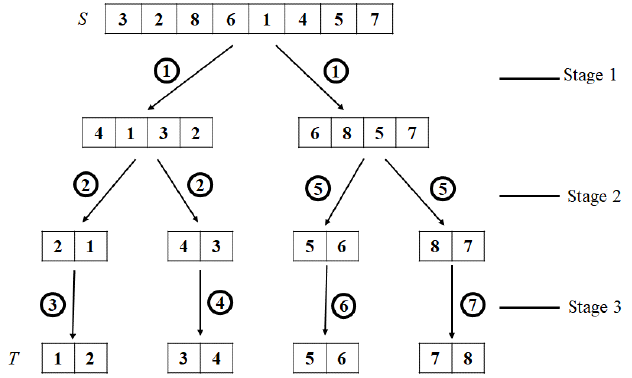
Figure 6. Separation() call steps and sequence in LS 8 . Figure 6. separation() call steps and sequence in LS 8 .